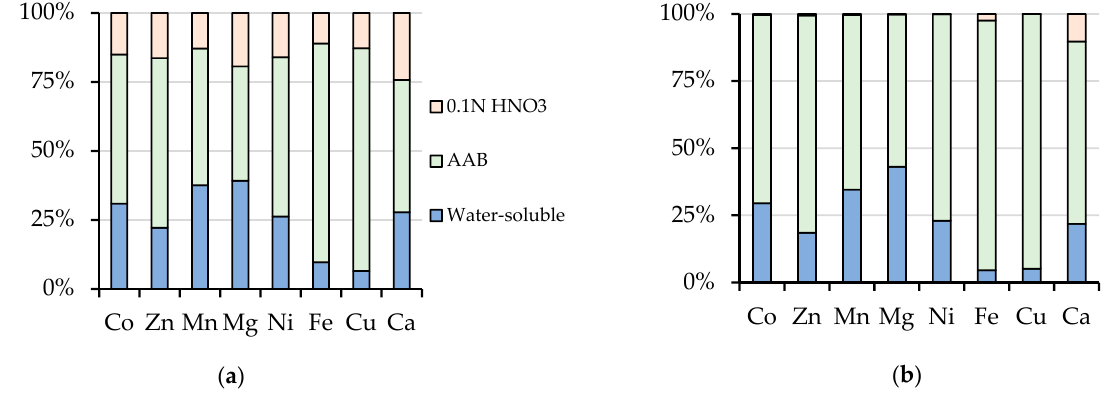
Figure 4. The ratio between the total content of water-soluble, AAB, and 0.1 N HNO 3 -extracted fractions of elements after a single ( a ) and sequential triple ( b ) treatment of peat with extracting solutions.